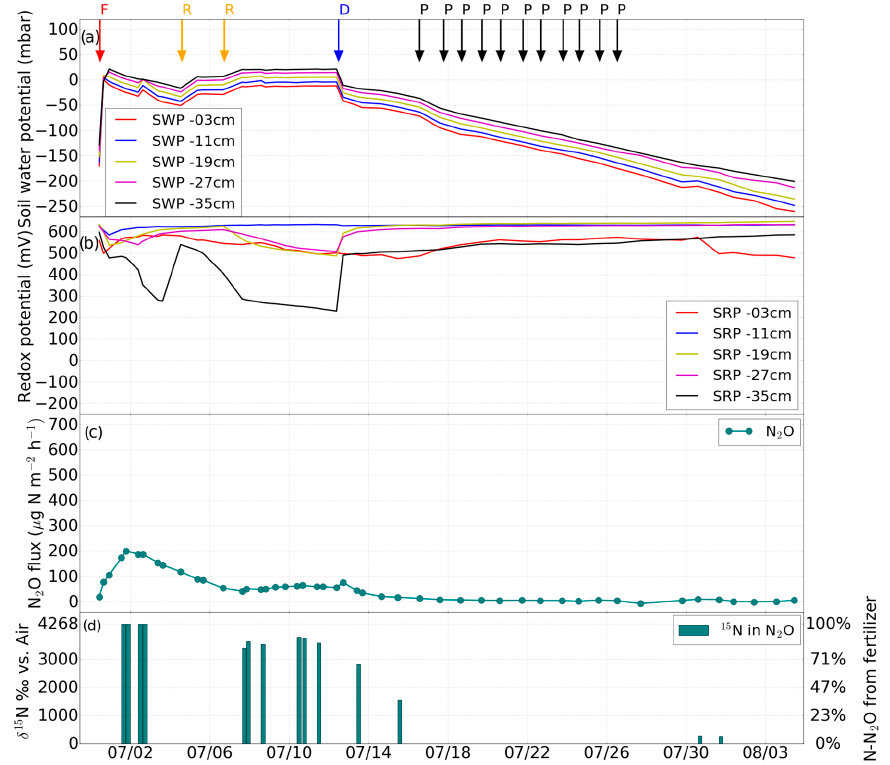
Figure 4. Experiment 3 (second fertilization). Changes in ( a ) soil water potential (SWP), ( b ) soil redox potential (SRP), ( c ) N 2 O flux induced by drainage (D), irrigation with fertilizer (F), desaturation of the soil with pump (P), water table rise (R), ( d ) percentage of N 2 O derived from the added fertilizer.